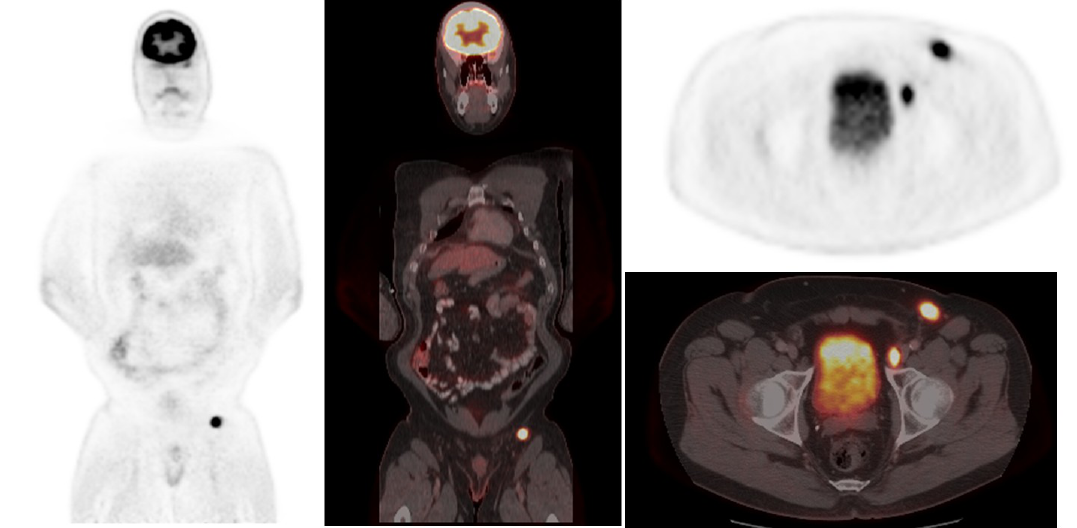
Figure 2. FDG PET/CT showing left inguinal node metastases in a patient with Merkel cell